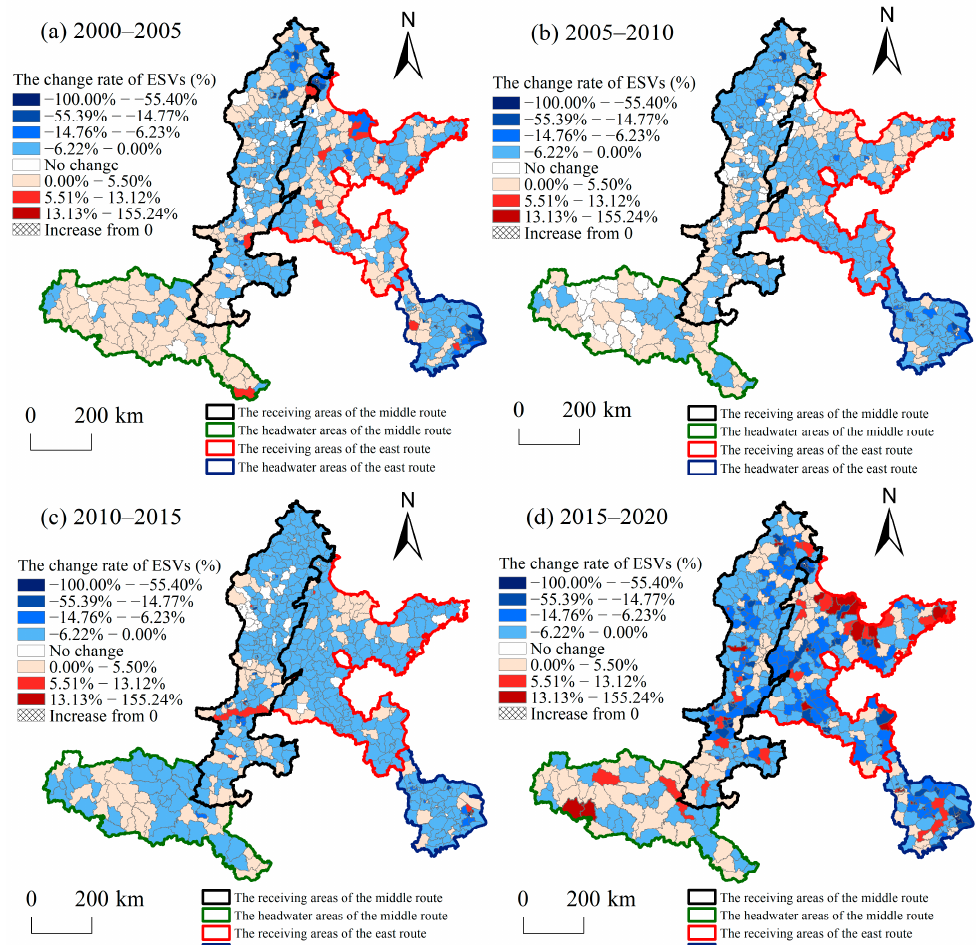
Figure 5. Change rates patterns of ecosystem service value in the study area during 2000–2005, 2005–2010, 2010–2015, and 2015–2020. ( a ) Change rates patterns of ecosystem service value in the study area from 2000 to 2005, ( b ) Change rates patterns of ecosystem service value in the study area from 2005 to 2010, ( c ) Change rates patterns of ecosystem service value in the study area from 2010 to 2015, ( d ) Change rates patterns of ecosystem service value in the study area from 2015 to 2020.